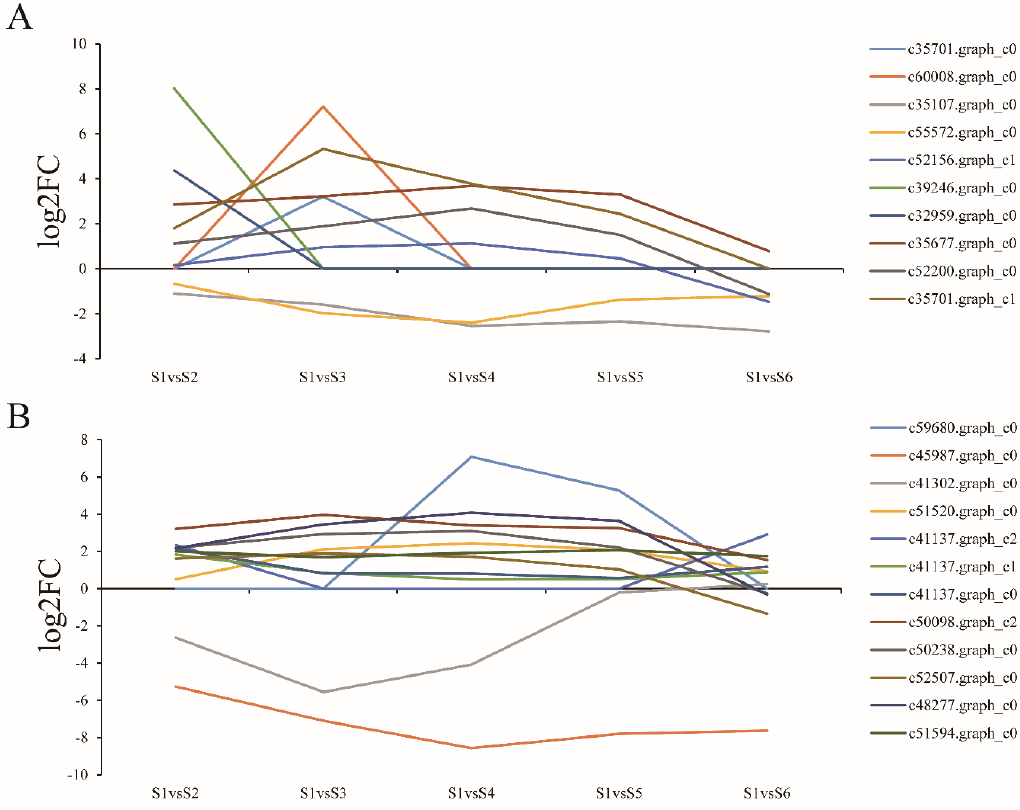
Figure 7. Gene expression profiling of clusters, showing log 2 of the fold change variations among the five time points. ( A ) The expansin gene and ( B ) the XTH gene.